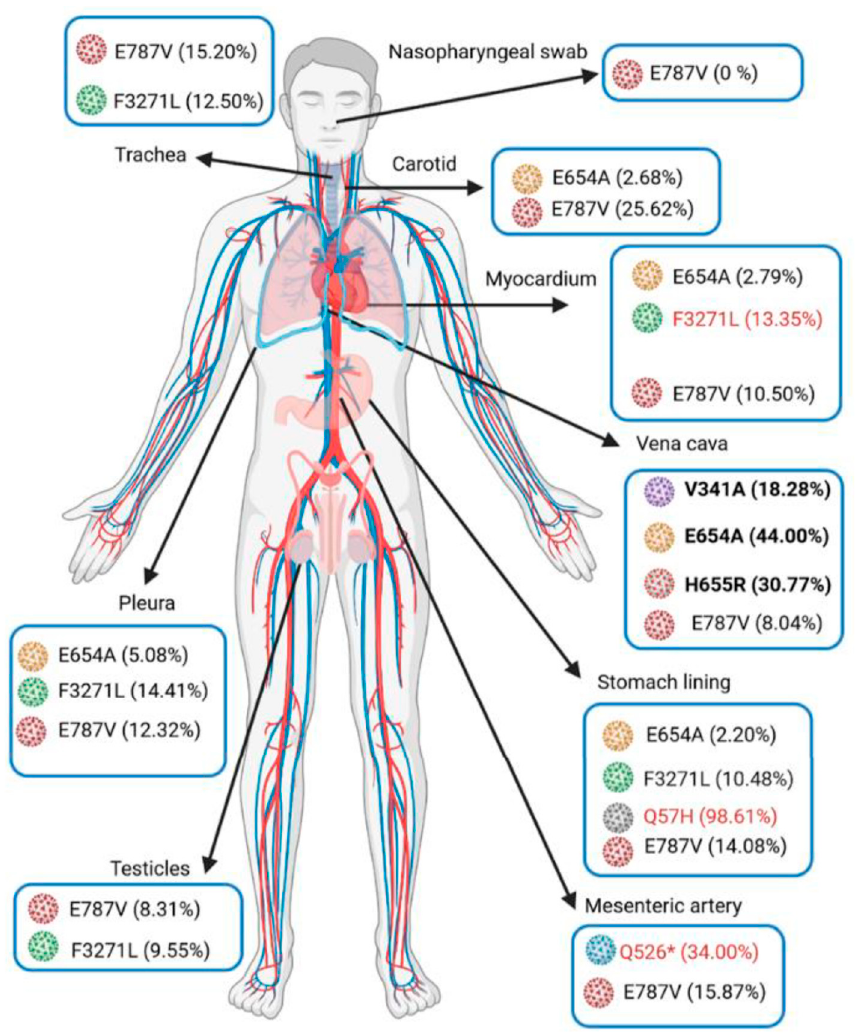
Figure 2. Anatomical diagram of variant distribution according to autopsied patient tissues. The amino acid colored in blue matches SARS-CoV-2 Wuhan-Hu-1 sequence (NC 045512.2: 21563-25384); amino acids with other colors match the mutated sequence (designed by biorender).